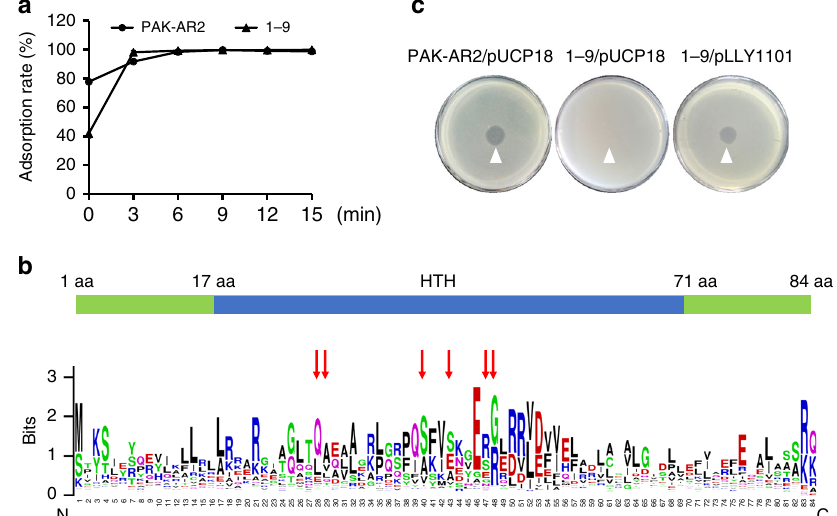
Fig. 1 Characterization of the srpA mutant. a Time course of the phage adsorption rate. PAK-AR2: sensitive to the phage K5. 1 – 9: resistant to the phage K5. b Protein structure of the SrpA. Red arrows represent the amino acids recognizing speci fi c DNA sequences. Larger letters represent higher conservative amino acid residues. c Complement test by spotting assay. Plasmid pLLY1101 carries a srpA gene. The experiment was independently replicated three times ( a ). Error bars show standard deviations. HTH helix-turn-helix DNA-binding